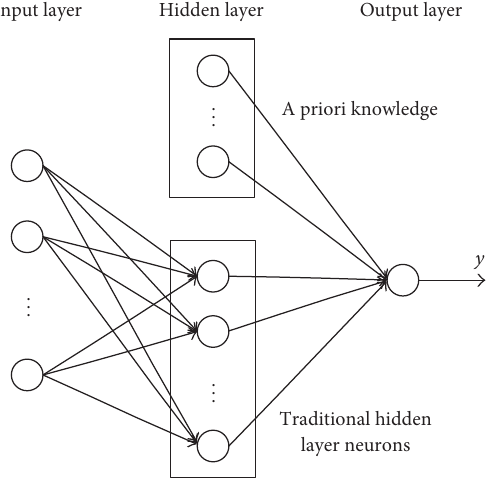
Figure 1: Structure of the proposed KBNN.